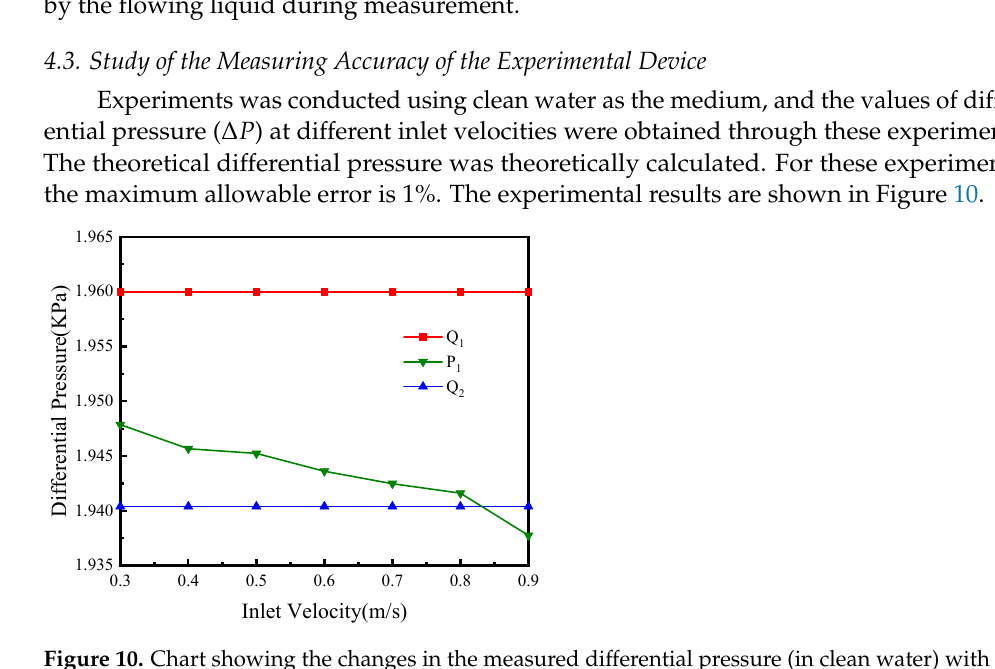
Figure 9. G raph showing the changes in turbulence intensity along the Y-axis with the inlet angle. ( a ) Changes in turbulence intensity along the Y-axis corresponding to L 1 . ( b ) Changes in turbulence intensity along the Y-axis corresponding to L 2 .